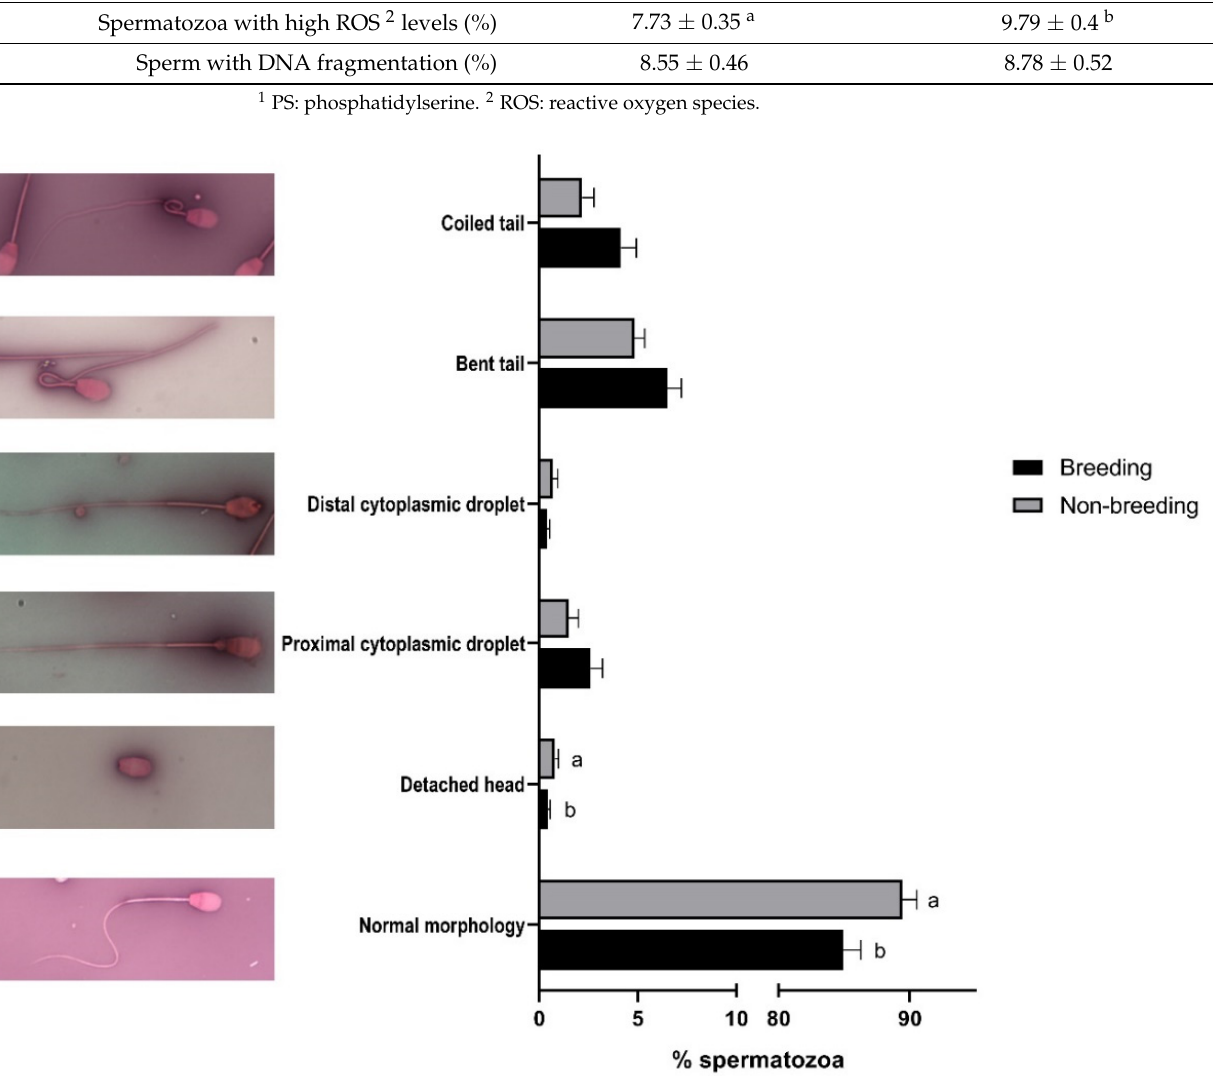
Figure 2. Seasonal differences in sperm capacitation state in Rasa Aragonesa rams. Results are shown as mean ± SEM of n = 56 (breeding season) and n = 40 (non-breeding season). Different letters indi- cate p < 0.05. Representative images of a non-capacitated, capacitated and acrosome-reacted sper- matozoa are also shown.